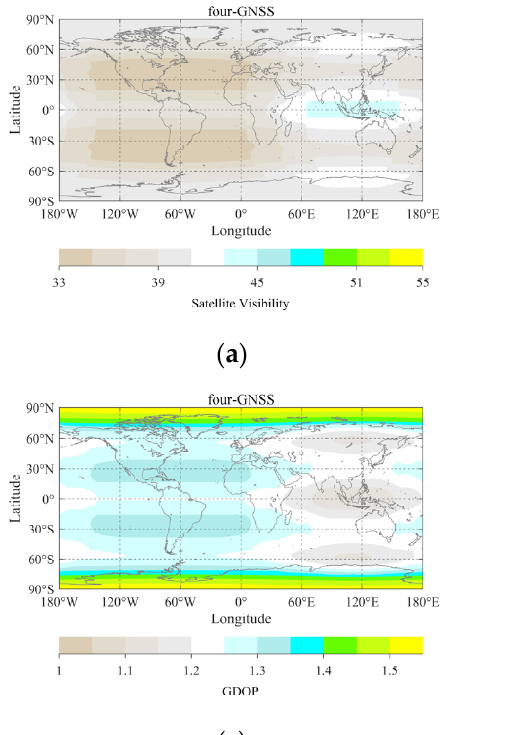
Figure 5. ( a ) visible satellites of GPS; ( b ) GDOP of GPS.